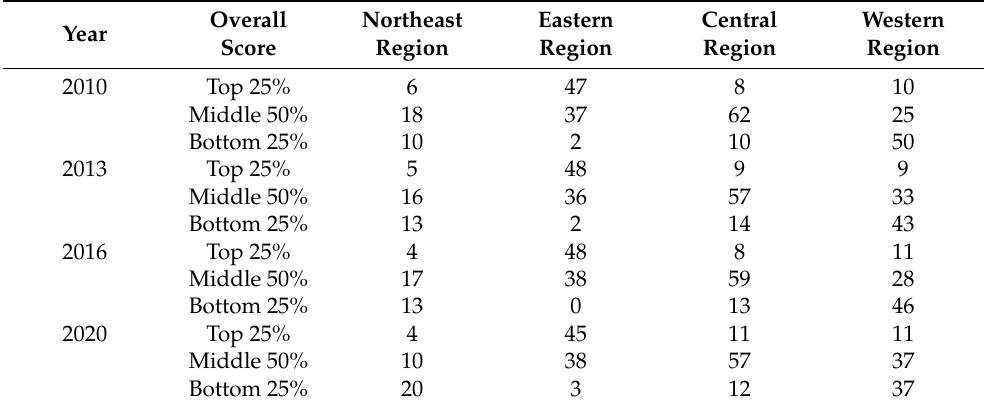
Table 6. Overall score of